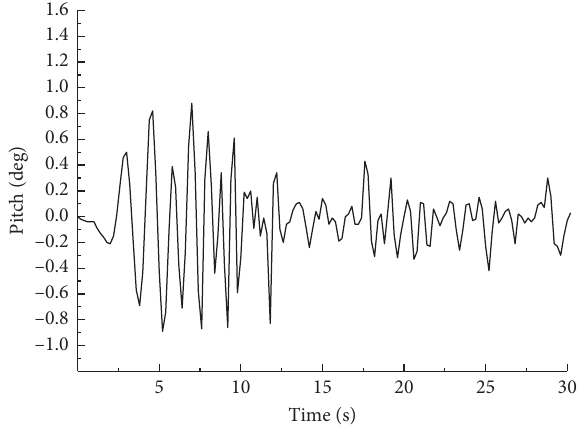
Figure 13: Time history curve of ship pitch in curved